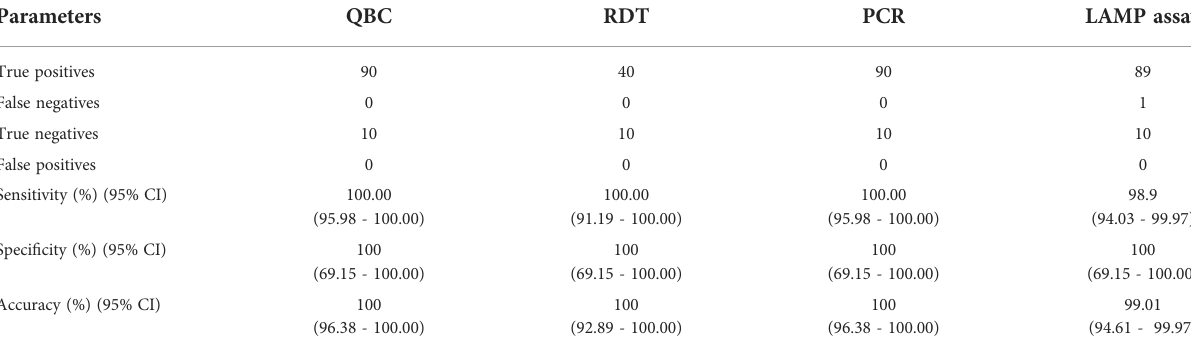
TABLE 3 Comparison of diagnostic test evaluation parameters of ITS-1 PCR and LAMP assay.